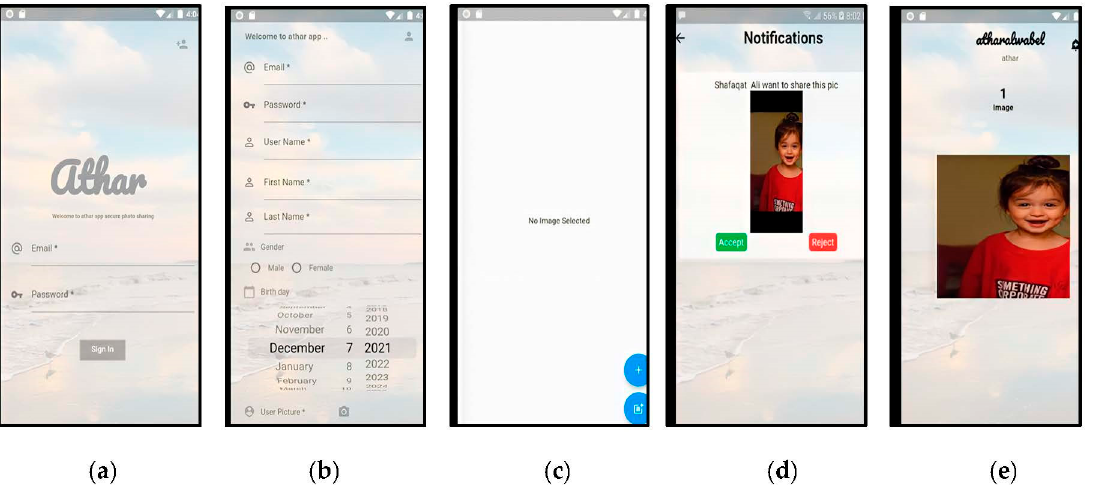
Figure A1. Screenshots of our mobile application. ( a ) refers to sign in page. ( b ) refers to sign up page. ( c ) refers to post images from the gallery or camera. ( d ) refers to the notifications the user received for accepting or rejecting. ( e )refers to the image publish after accept.